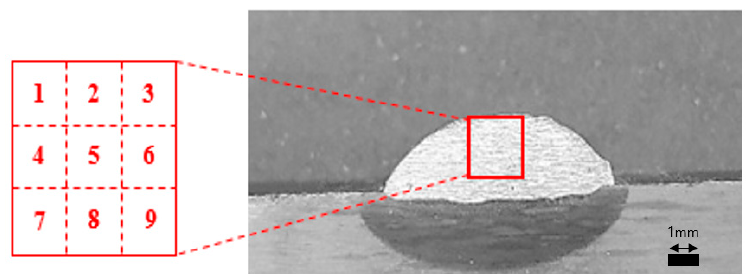
Figure 5. Measurement section of the welding bead.